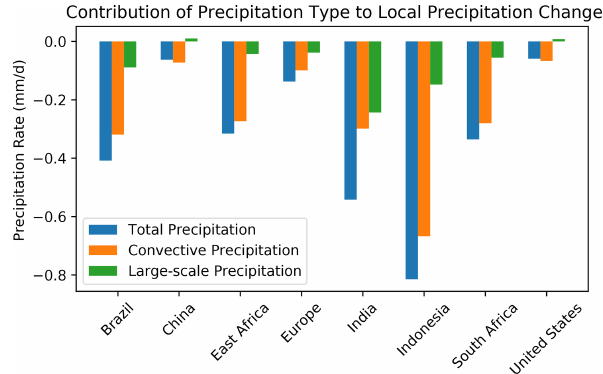
Figure A8. The relative contribution of convective precipitation change (mmd − 1 , orange) and large-scale precipitation change (mmd − 1 , green) to the total local precipitation response (mmd − 1 , blue) within each of the eight perturbation regions in response to emissions within that region are